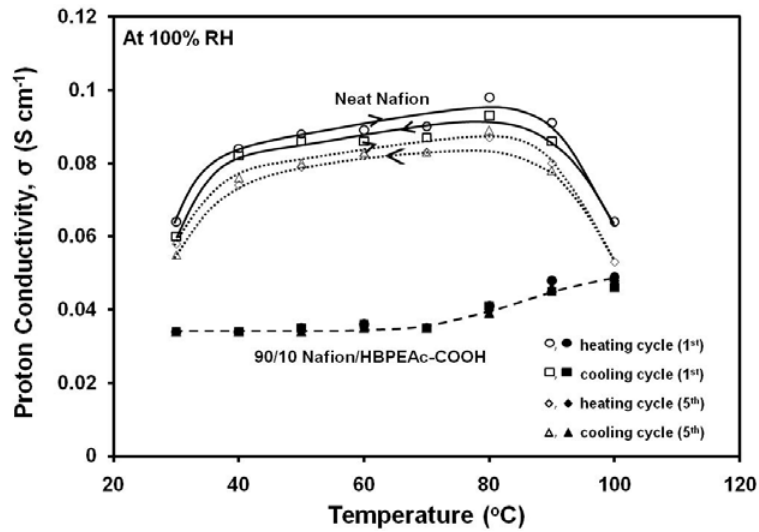
Figure 13. Heating and cooling cyclic AC impedance measurements of neat Nafion and impregnated membrane at 100% RH demonstrating the lowering of the proton conductivity hysteresis of neat Nafion after each cycle. The impregnated membrane, however, shows relatively consistent proton conductivity after all five cyclic